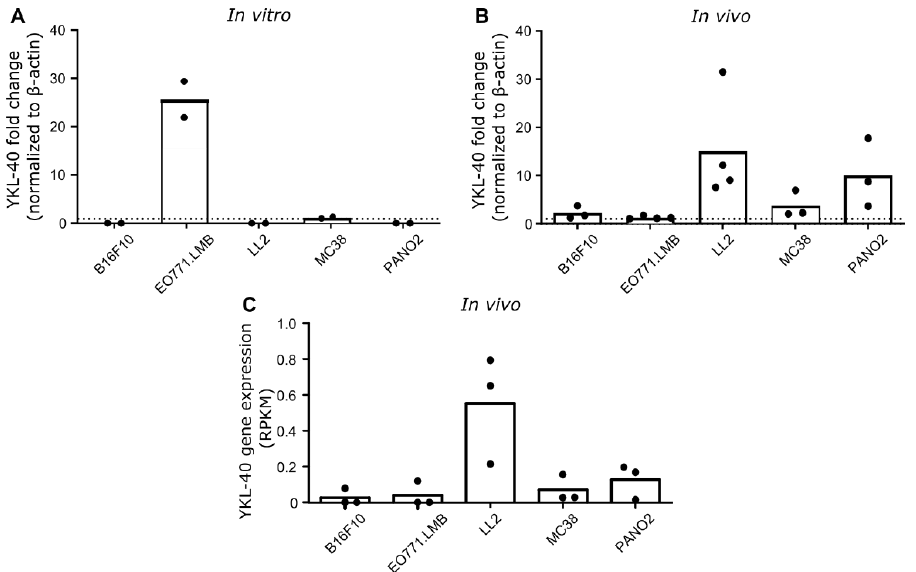
Figure 2. YKL-40 gene expression in mouse cancer cell lines and engrafted tumors. RNA was isolated from ( A ) cultured cell lines ( n = 2 per group) and ( B ) engrafted tumors ( n = 3–4 per group), and YKL-40 expression levels were analyzed with RT-qPCR. Samples were run in technical tripli- cates, and expression levels were normalized to the β-actin housekeeping gene and illustrated as fold change compared to the cell line with the lowest expression level (mean). Dotted line at y = 1. ( C ) YKL-40 gene expression after sequencing of RNA isolated from engrafted tumors ( n = 3 per group) (mean). Abbreviations: RPKM, reads per kilobase million.